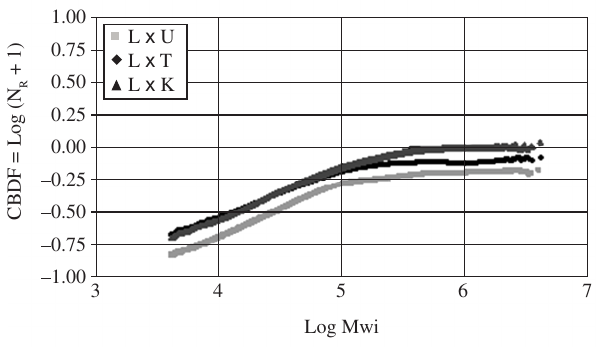
Figure 3. Chain Branching Distribution Function from the comparison of the reference curve (L-powder) with the other curves (K, U, and